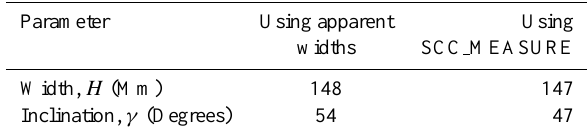
Table 1. Observed width and position parameters the filament. Table 2. Estimated width and inclination of the